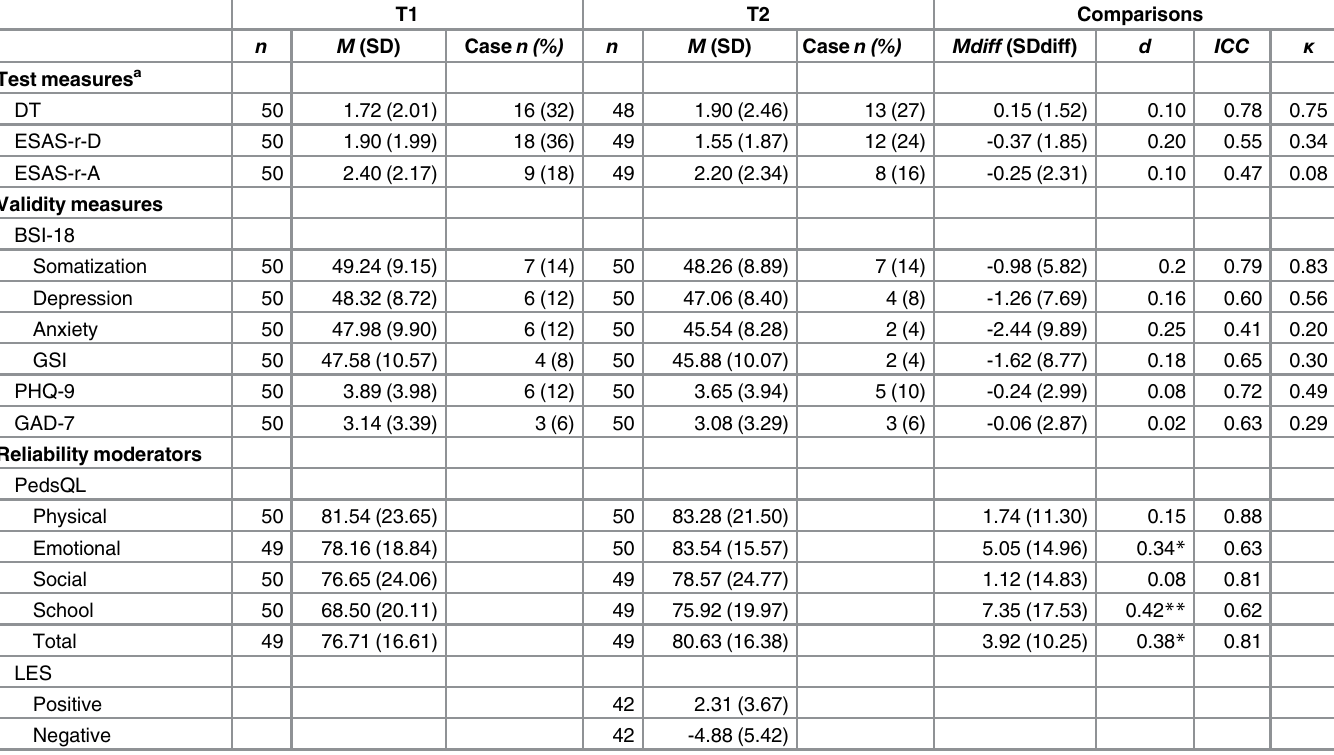
Table 2. Stability and repeatability